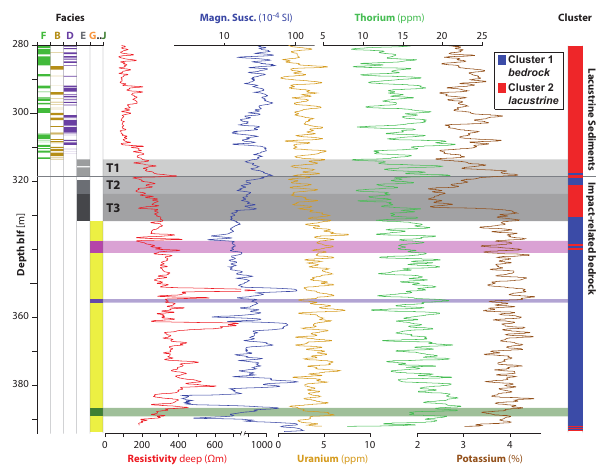
Fig. 5. Facies and downhole logging data of the transitional zone between impact-related bedrock and lake sediments. Facies descrip- tion as in Fig. 3. Clusters derived from k-mean clustering of down- hole logging data are shown in blue for cluster 1 ( = bedrock) and red for cluster 2 ( = lacustrine). The impact breccia/suevite succes- sion according to Koeberl et al. (2012) is given as follows: yellow: suevite; lilac: upper volcanic rock layer; violet: lower volcanic rock layer; green: